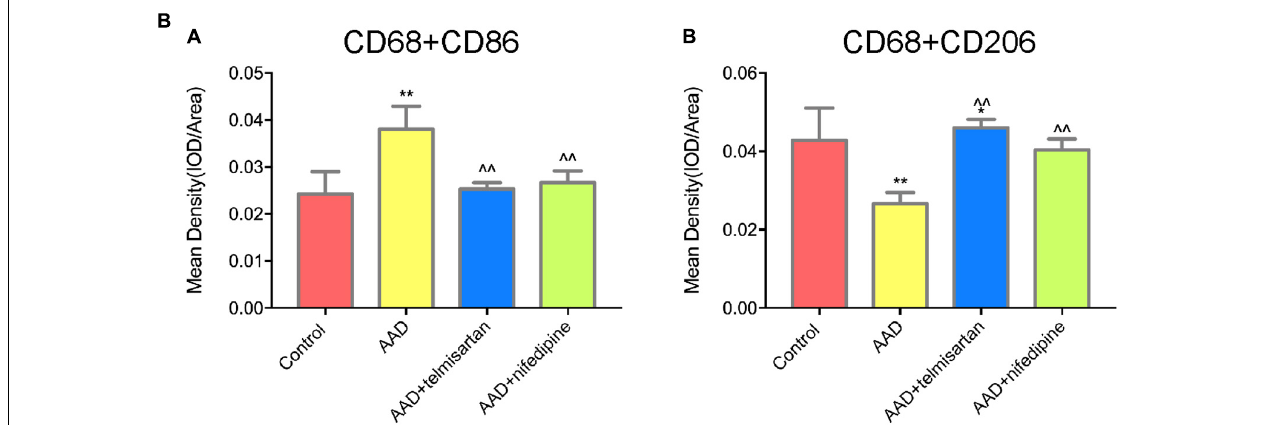
FIGURE 7B | Quantification of tissue fluorescent staining images. (A) Quantification of M1 macrophages (CD68 + /CD86 +) tissue fluorescent staining images. (B) Quantification of M2 macrophages (CD68 + /CD206 +) tissue fluorescent staining images. * P < 005 compared with control group; ** P < 0.01 compared with control group; ˆˆ P < 0.05 compared with AAD